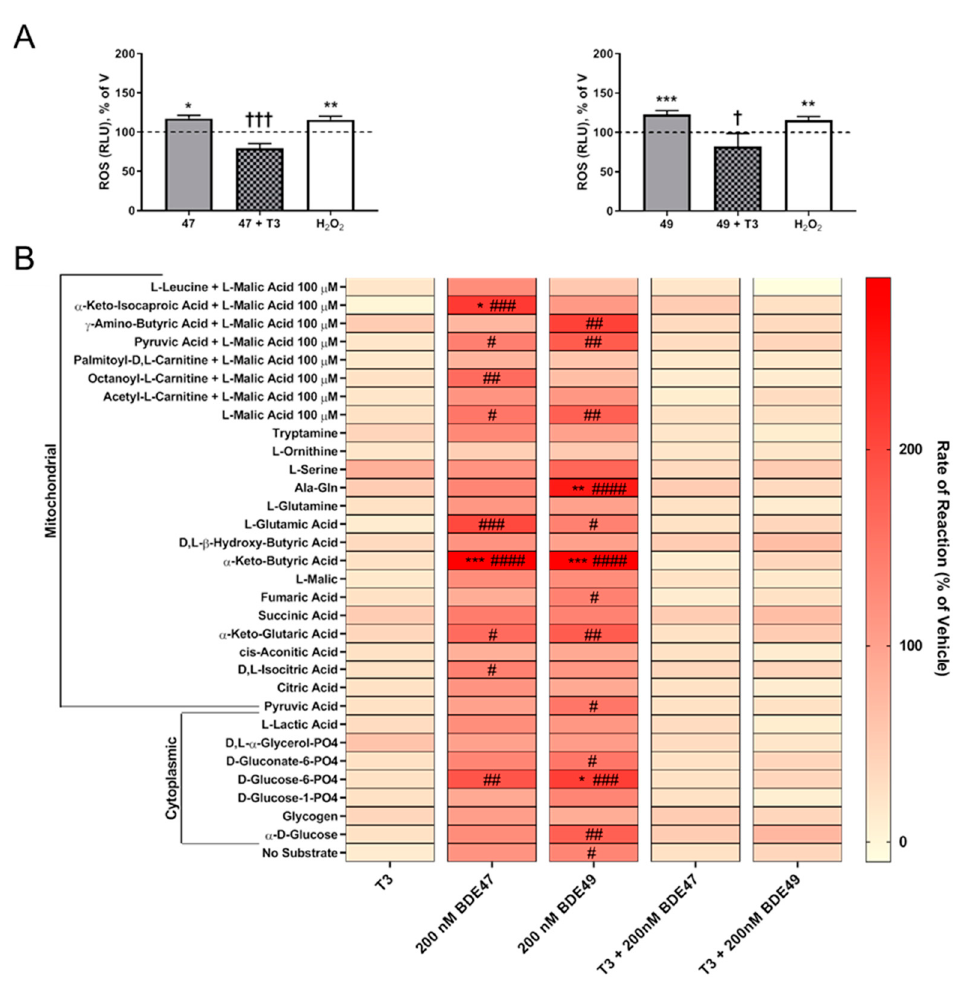
Figure 4. T3 normalized ROS levels and mitochondrial substrate metabolism in cultures exposed to BDE-47 or BDE-49. Hippocampal neuron-glia co-cultures were exposed to vehicle, T3, BDE-47 and/or BDE-49 for 1 h on DIV 2. ( A ) Quantification of ROS production following co-exposure to T3 and PBDEs. ( B ) Mitochondrial substrate metabolism kinetics immediately following PBDE exposure alone and in the presence of T3. Data presented as the mean ± SE ( n = three independent dissections). * Significantly different from vehicle at * p < 0.05, ** p < 0.01, *** p < 0.001; # significantly different from T3 at # p < 0.05, ## p < 0.01, ### p < 0.001, #### p < 0.0001 as determined by one-way ANOVA followed by Dunne tt ’s post hoc test; †signi fi cantly di ff erent from individual PBDE